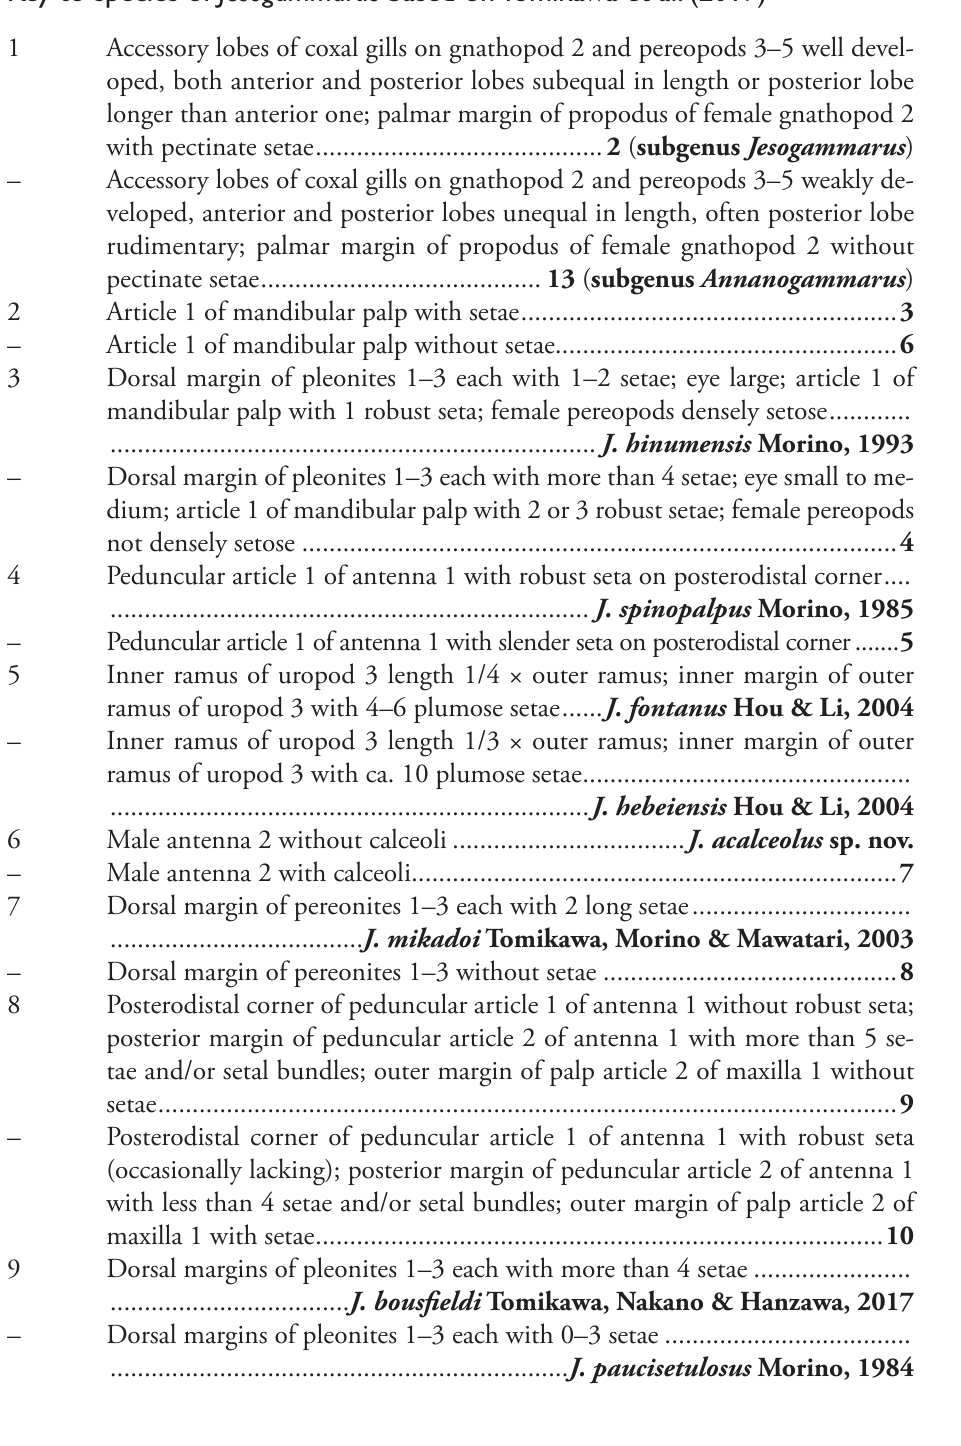
Accessory lobes of coxal gills on gnathopod 2 and pereopods 3–5 well devel- oped, both anterior and posterior lobes subequal in length or posterior lobe longer than anterior one; palmar margin of propodus of female gnathopod 2 with pectinate setae .......................................... 2 ( subgenus Jesogammarus ) – Accessory lobes of coxal gills on gnathopod 2 and pereopods 3–5 weakly de- veloped, anterior and posterior lobes unequal in length, often posterior lobe rudimentary; palmar margin of propodus of female gnathopod 2 without